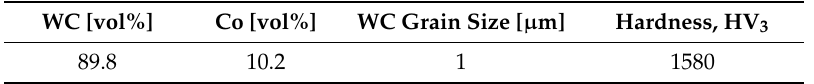
Figure 1. Microstructure of the cemented carbide grade investigated. WC phase appears bright, Co phase appears dark. Table 1. Hardness and chemical composition of the tool grade according to the material specification provided by AB Sandvik Coromant.